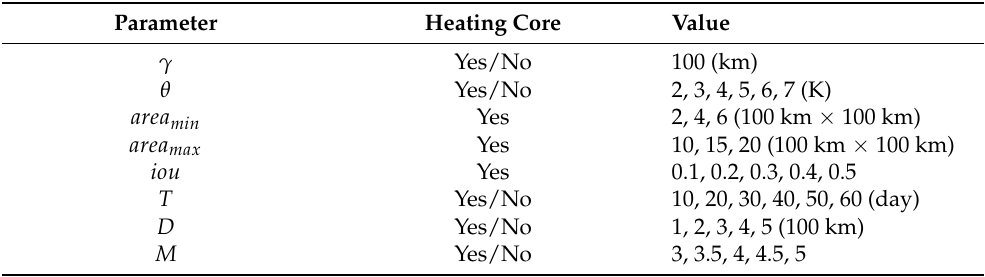
Table 3. Candidate parameters for models with/without a “heating core” when the resampling scale is 100.